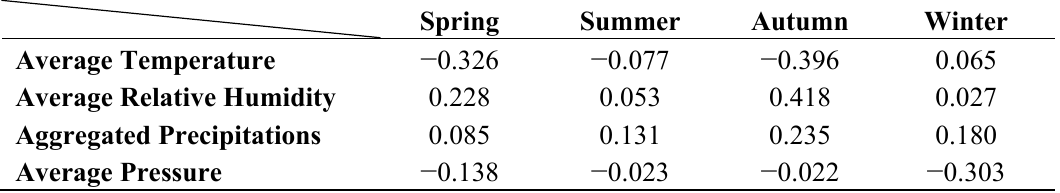
Table 2. Seasonal correlation coefficient between weather variables and electric power